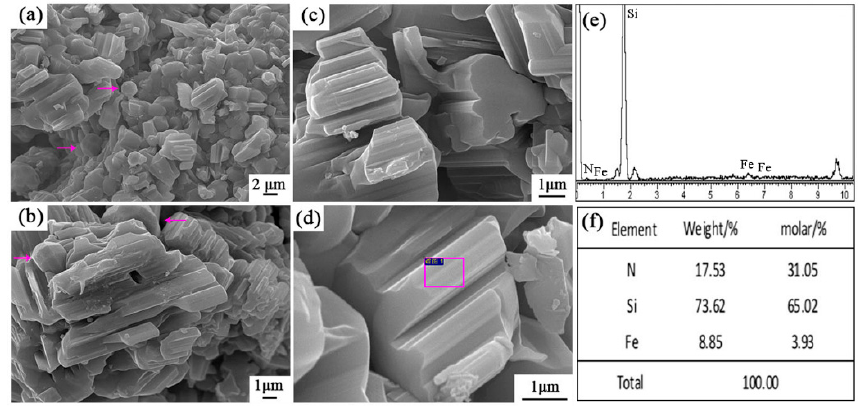
Table 3. Weight fraction of each phase in S1 and S5 at 1570 and 1600 °C (wt. %).